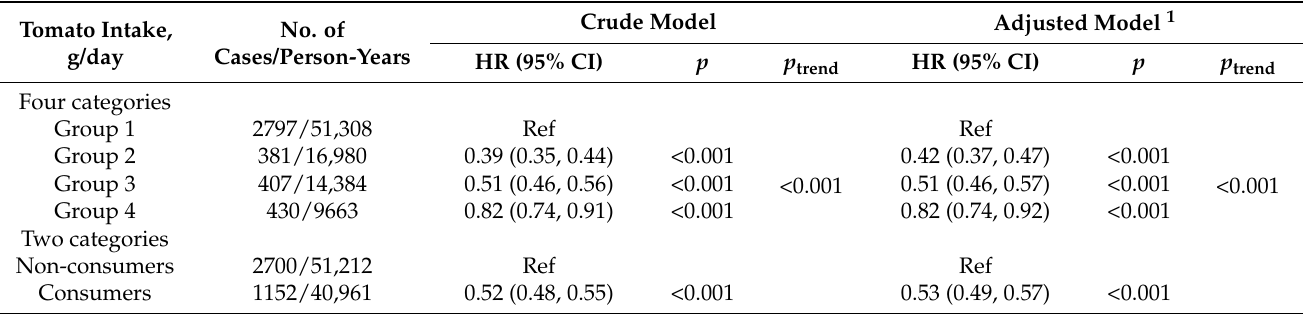
Table 2. The relationship of tomato intake with risk of new-onset hypertension.